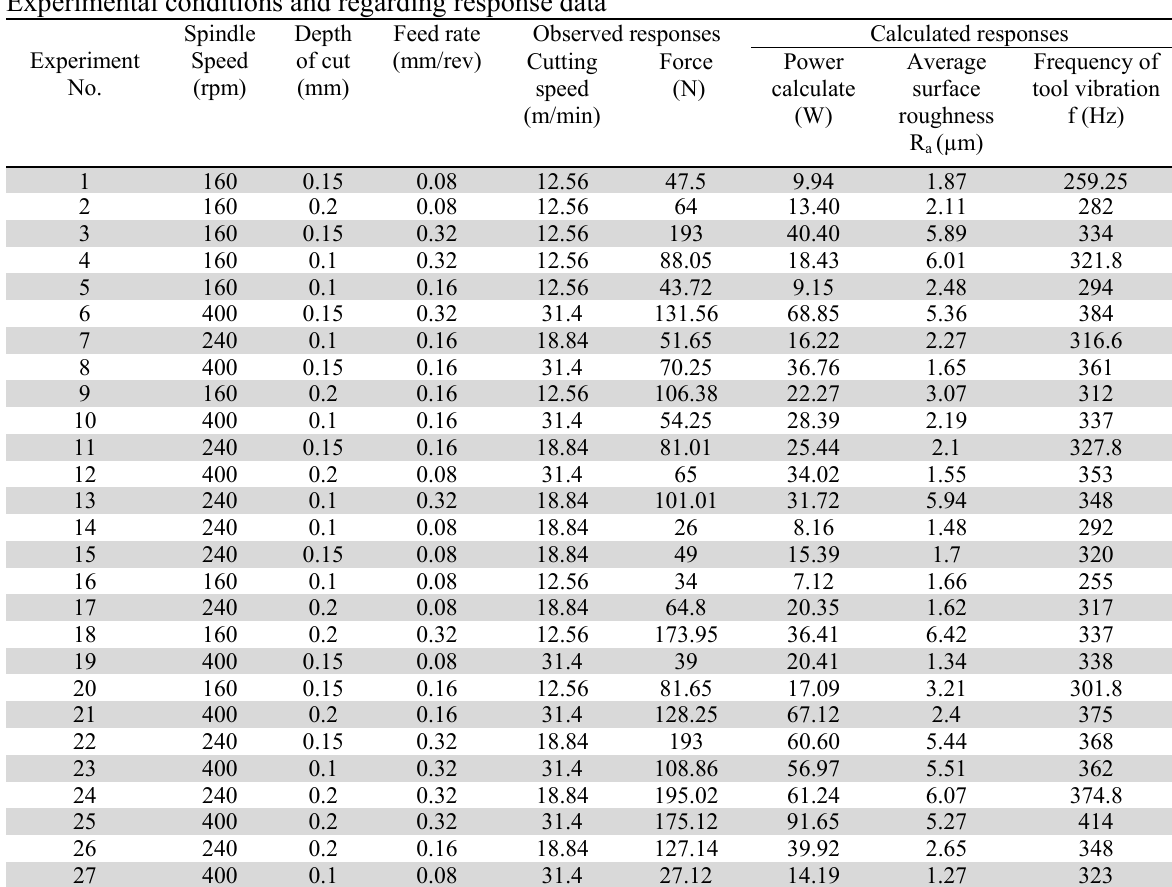
Experimental conditions and regarding response data